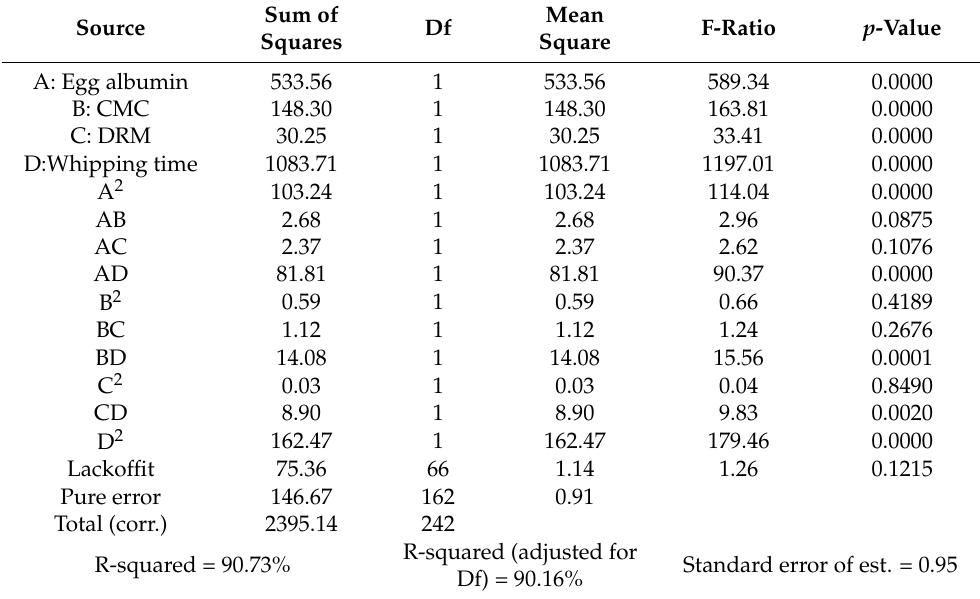
Table 3. Analysis of variance for foam stability.